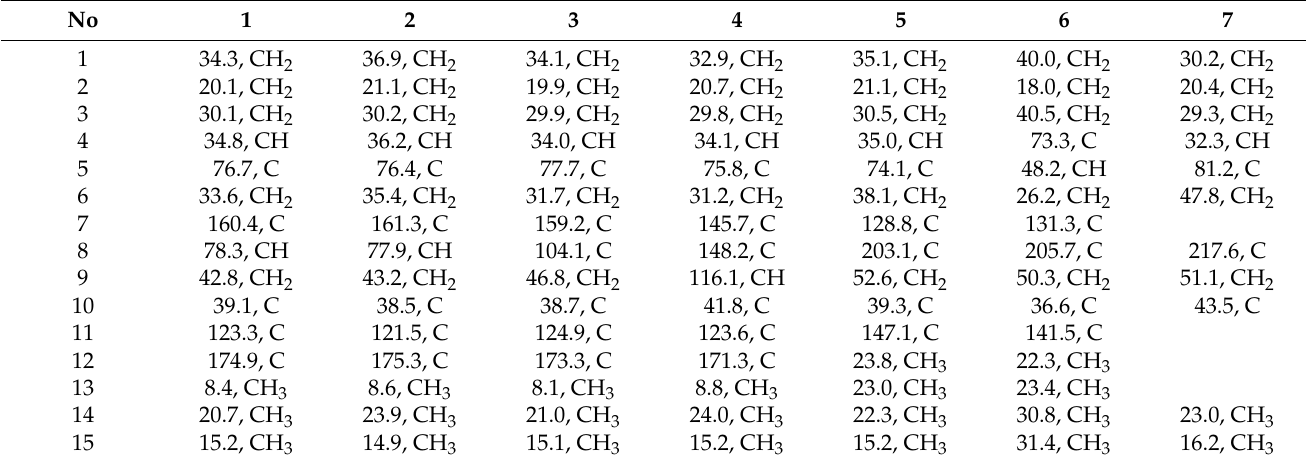
The comparisons of 1D NMR data between compound 1 and herticin A [14] revealed that they were structural analogs and the major differences were the different appendances at C-5 and C-10 positions. In detail, herticin A was a hydroxyl attached to the C-10 and a methyl attached to the C-5, while there was a hydroxyl and a methyl group attached to the C-5 and C-10 position, respectively, in 1 , whereas they were opposite in herticin A. This conclusion was supported by the HMBC correlations of OH-5/C-5, C-6, and C-10; H 3 -14/C-1, C-9, and C-10 (Figure 2).